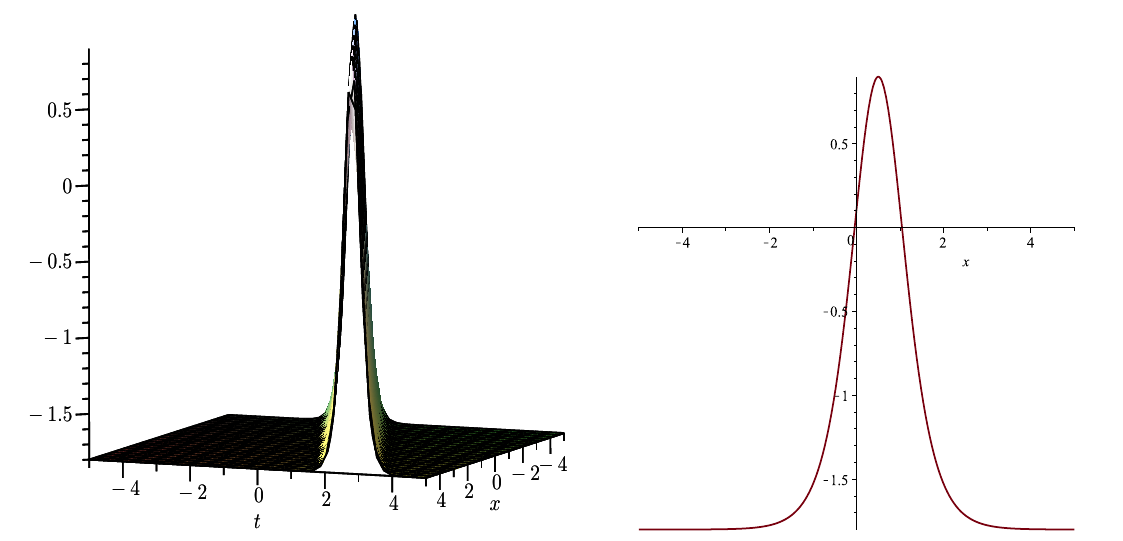
Figure 3. ( left ) 3D representation of solution (28) for ν = 1.5, κ = 1, ω = x , t ξ 0 = 2 and 5 5. ( right ) 2D representation of solution (28) for t = 1 and − ≤ ≤ soliton.